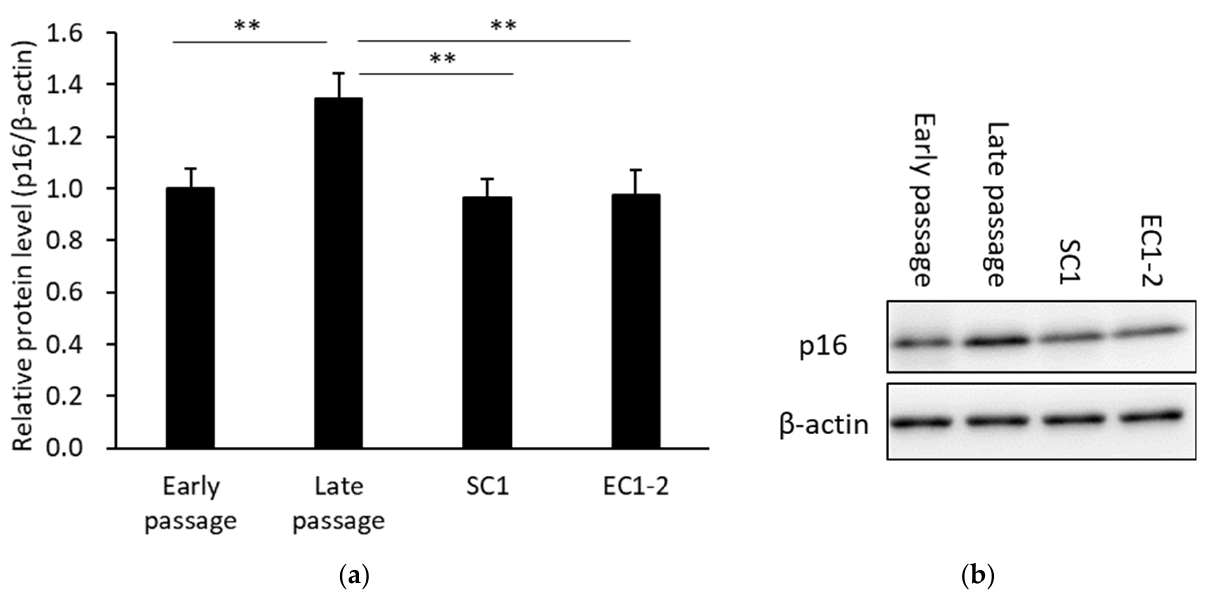
Figure 3. Effects of SC1 and EC1-2 on the cellular senescence marker p16 ( a ). The relative protein level of p16 normalized with β -actin is evaluated by western blotting. Representative western blot images of p16 and β -actin are shown ( b ). Data were reported as means ± SD of three independent experiments. **; p < 0.01 vs. Late passage group by Dunnett’s test.